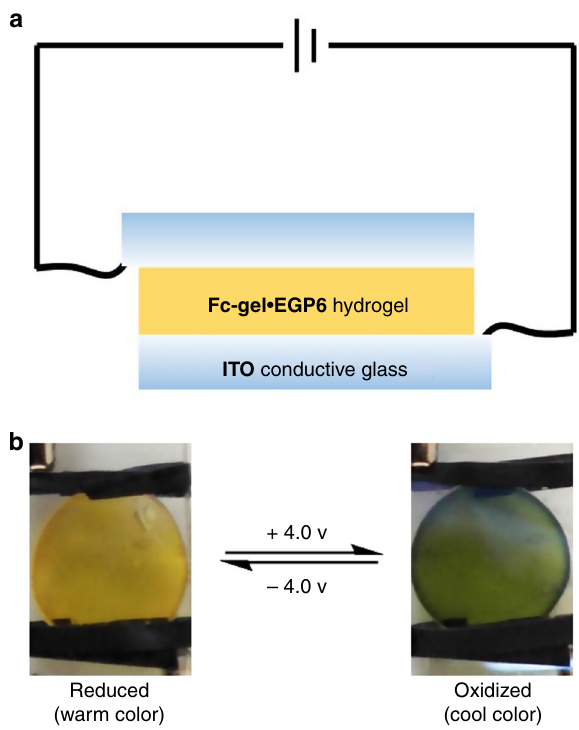
Fig. 8 An electrochemical device based on Fc-gel (cid:129) EGP6 hydrogel. a Schematic illustration of the electrochemical device based on Fc-gel (cid:129) EGP6 hydrogel; b Photographs of the device in reduced and oxidized states,